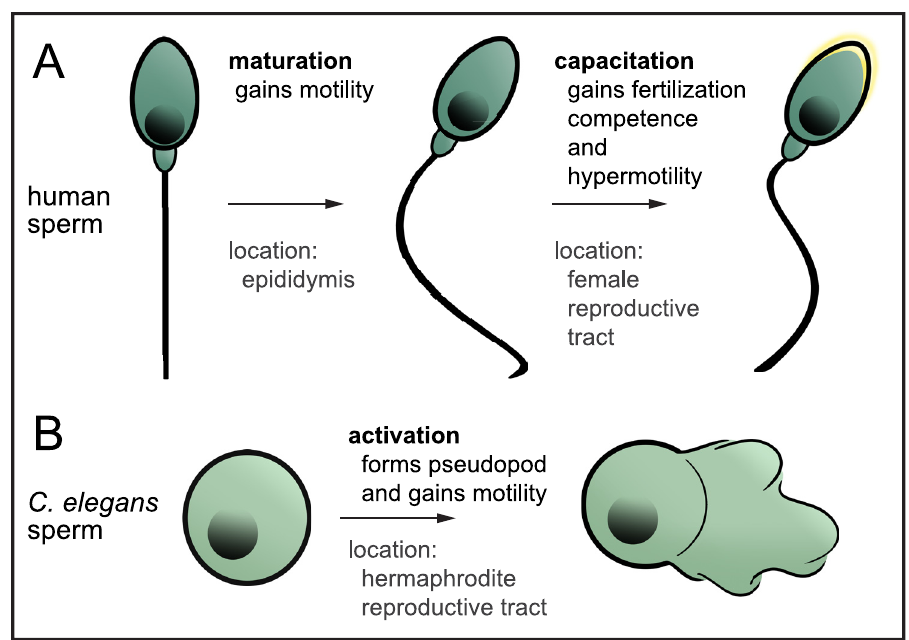
Fig 1. Schematic representations of stages of sperm motility activation. (A) In humans, sperm are formed during spermatogenesis in the seminiferous tubules but are not motile nor competent to fertilize. During transit and storage in the epididymis, they undergo maturation to gain the ability to move. Upon delivery into the female reproductive tract, sperm become capable of fertilization through a process called capacitation, which alters the sperm head membrane to allow for membrane fusion and causes the sperm to become hypermotile. (B) In C . elegans , sperm are formed during spermatogenesis in both hermaphrodites and males. When males mate to hermaphrodites or when hermaphrodites switch to oocyte formation, sperm become activated. This activation causes the formation of the pseudopod that allows the sperm to crawl.